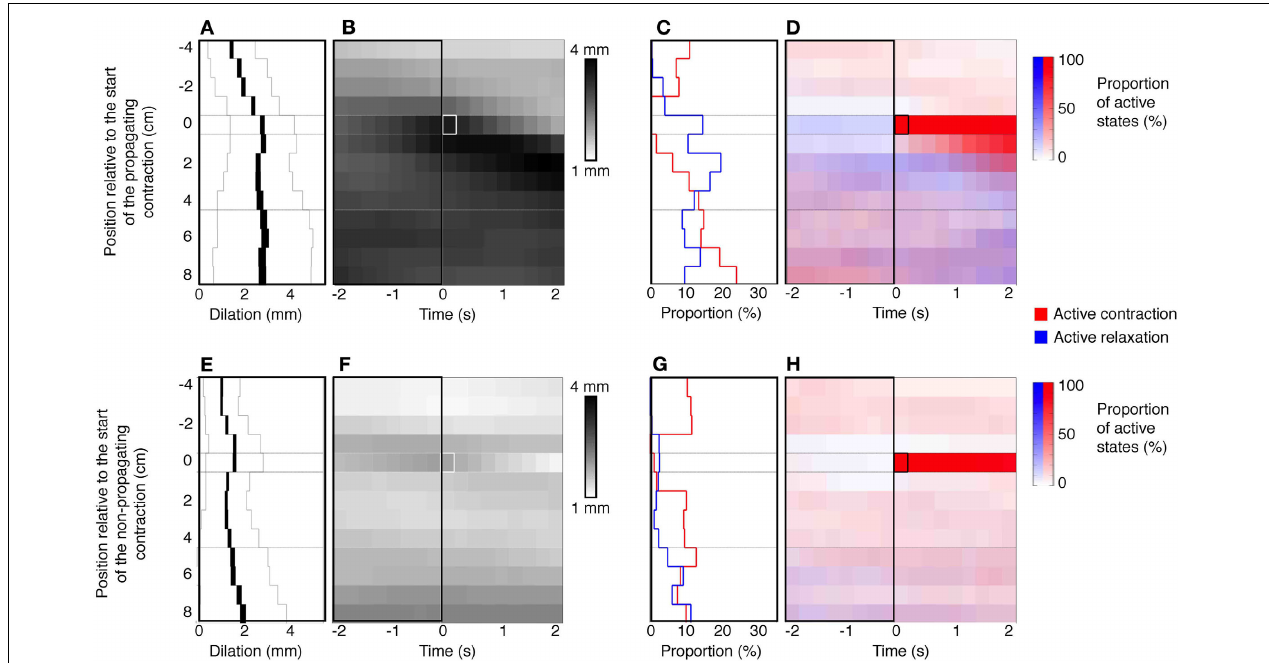
FIGURE 9 | Defining a stimulus for propagating contractions. The top panels (A–D) represent the data from propagating contractions. The bottom panels (E–H) are collated from non-propagating contractions. The panels (B,F) represent the mean dilations (increase from baseline diameter) in a 4cm region above and 8cm region below the site of initiation of the active propagating ( white box in B) and active non-propagating ( white box in F) contractions. All active propagating and non-propagating contractions that originated within the proximal 4cm or distal 8cm of the preparation were excluded from this analysis. These panels also capture a 2s time epoch leading up to and following the active contractions. (A,E) Indicated the mean dilation in the 2s period prior to the initiation of the active contractions. The